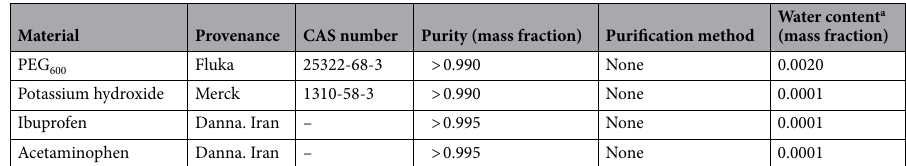
Table 1. Descriptions of the used chemicals. a Determined by Karl–Fischer